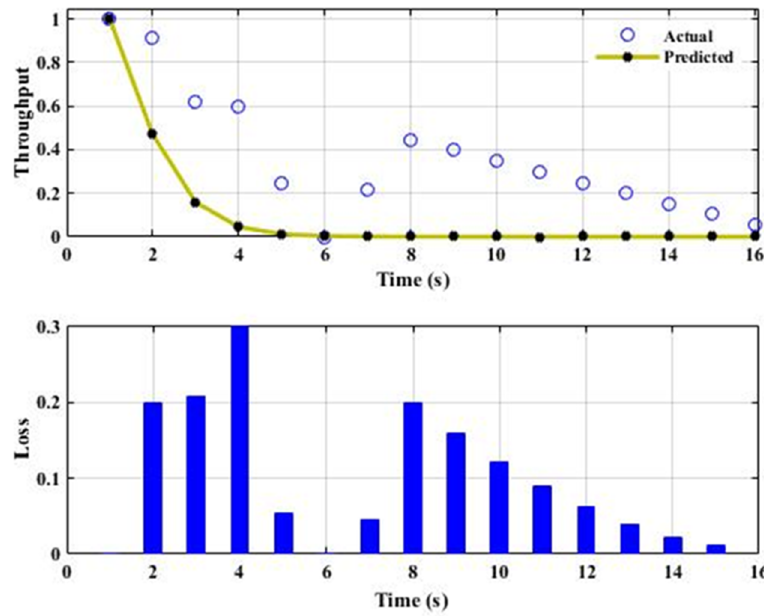
Figure 5. The predicted output at a transmission rate of 8 packets/s.